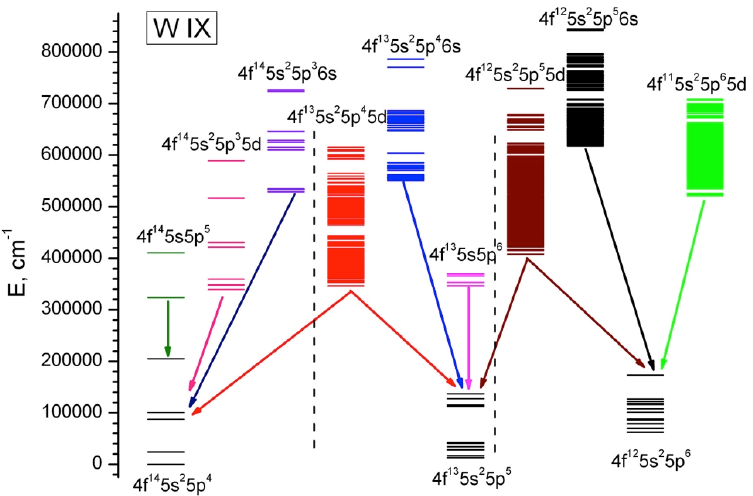
Figure 9. Low-lying energy levels of W IX according to Hartree-Fock calculations. Dashed vertical lines divide systems formed by excitation of the three lowest configurations: 4f 14 5s 2 5p 4 , 4f 13 5s 2 5p 5 , and 4f 12 5s 2 5p 6 . Arrows indicate electric dipole transitions between the configurations.